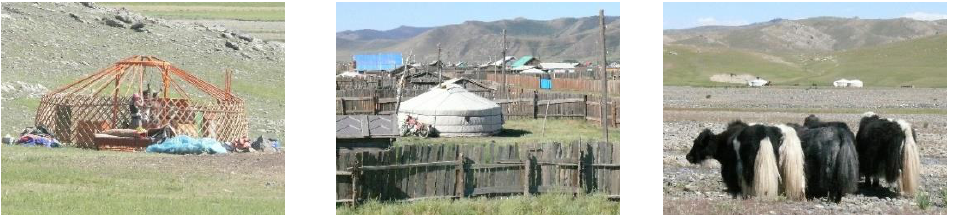
Figure 2. Original Mongolian Yurt: (Photographs taken by Piotr Śliwiński during his expedition to Mongolia in 2008).